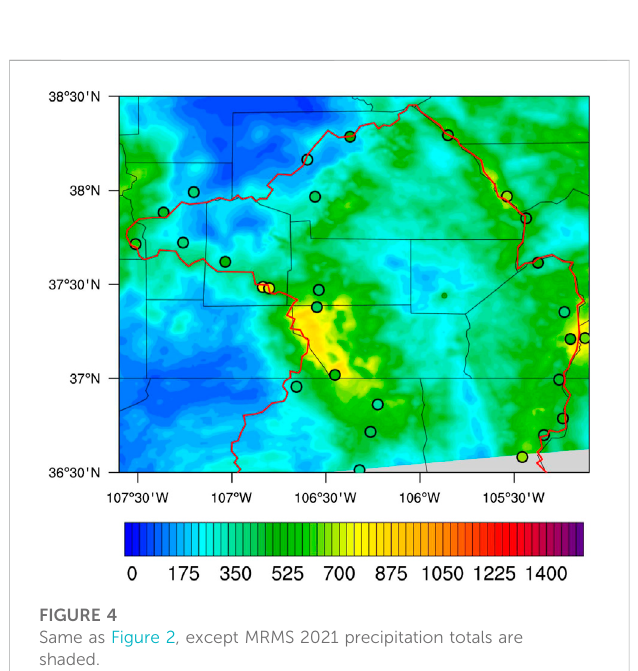
FIGURE 5 Percentage difference between MRMS and NLDAS 2021 precipitation